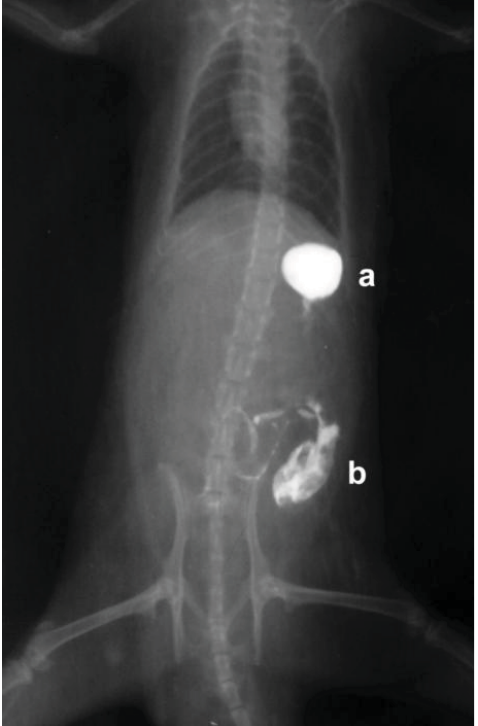
Figure 6. Contrast facial radiographs of a tacrine-treated rat 24 h is found only in the CM after administration of CM. BaSO 4 store in the stomach (a) and the cecum (b).